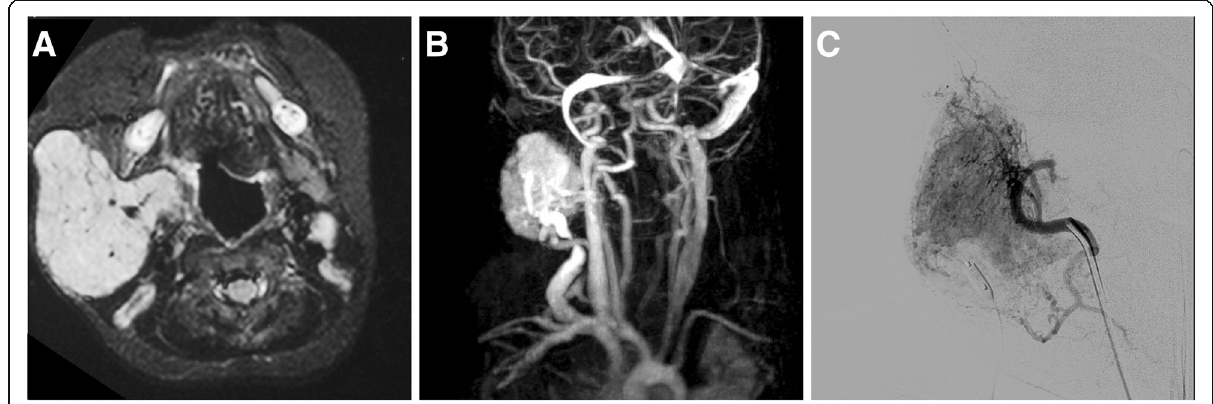
Fig. 4 Embolization therapy in large infantile hemangioma with extensive perfusion. In MRI, the hemangioma presents as a rather homogeneous, solid mass with central flow voids ( a ). Dynamic MR-A shows massive AV shunting during the early venous contrast phase ( b ). Transarterial particle embolization was performed to reduce the flow and induce a regression with a protection balloon in the draining vein ( c